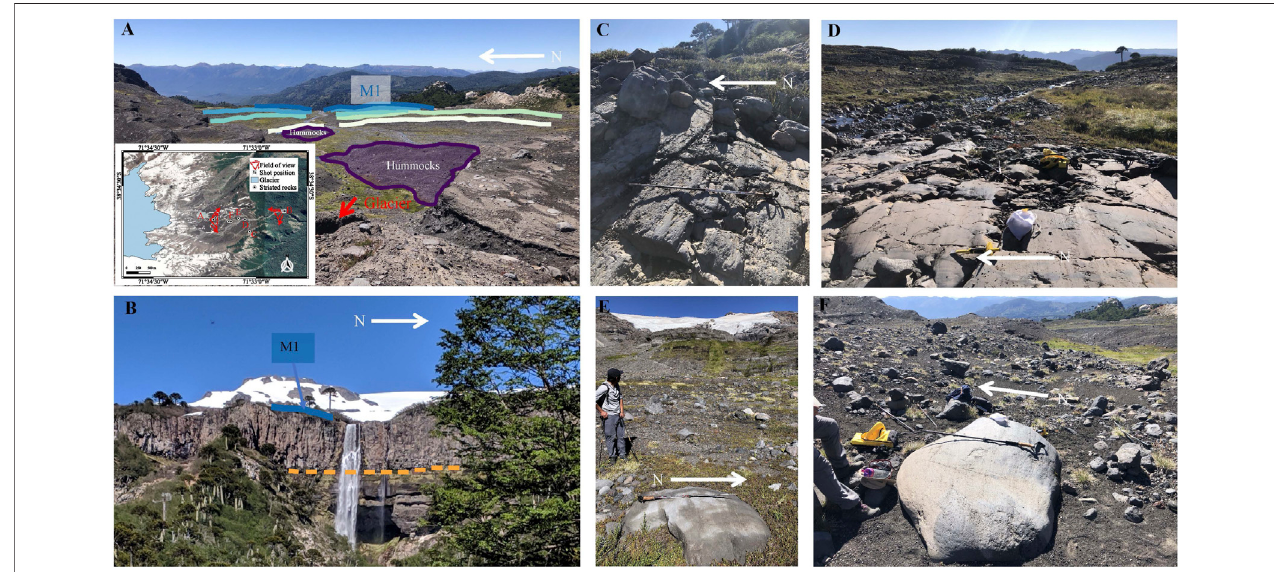
FIGURE4| PhotographsoftheMonteSierraNevada fi eldsite.Panel (A) Facingeastthehummockyareasofthe fi eldsiteareoutlinedontheglacierproximalsideof moraine M5 (purple). Panel (B) Facing west with the modern glacier in the background and contact between Pleistocene and Miocene volcanic rocks (orange dashed line)intheforegroundbehindwaterfall.ThecliffmarksthelimitofpreservedNeoglacialmoraineboulders,withmoraineM1(blueline)denotedtothesouthofthewaterfall. The combined effects of topoclimatic constrains (i.e., lower elevations, seasonally constrained snow accumulation) make the existence of large glaciers in CSCh unlikely,asNeoglaciallandformsaregenerallyindistinguishablebelowthisabruptchangeinelevation.Agroveof A.araucana treesispicturedtothesouthofthewaterfall in the foreground. Panel (C – F) Striated boulders and roches moutonnées used for directional data to infer paleo- fl owlines of the glacier. Inset map in panel A shows the location of each fi eld picture, with letters corresponding to each panel.